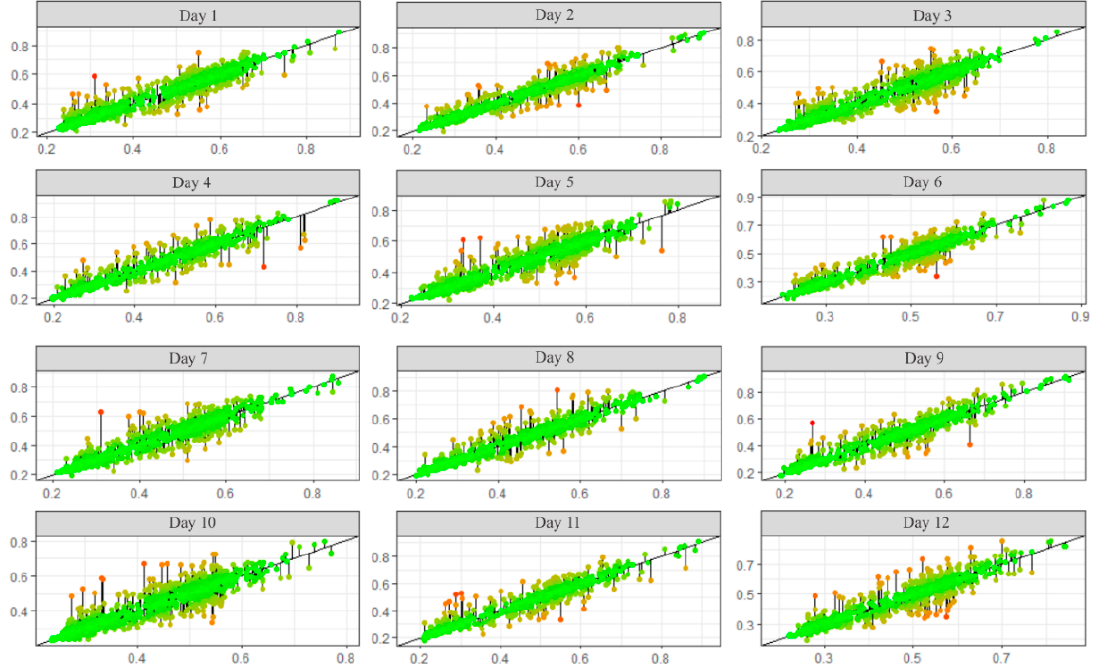
Figure 7. Observed NDVI from MODIS (X) versus predicted (Y) values of NDVI MODIS for the